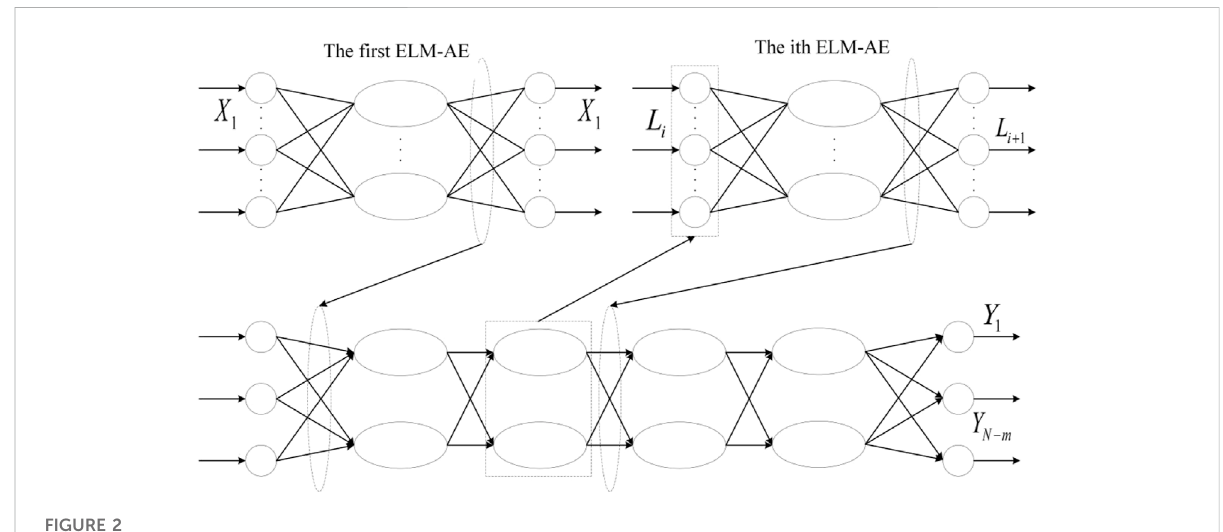
FIGURE 2 DELM structure